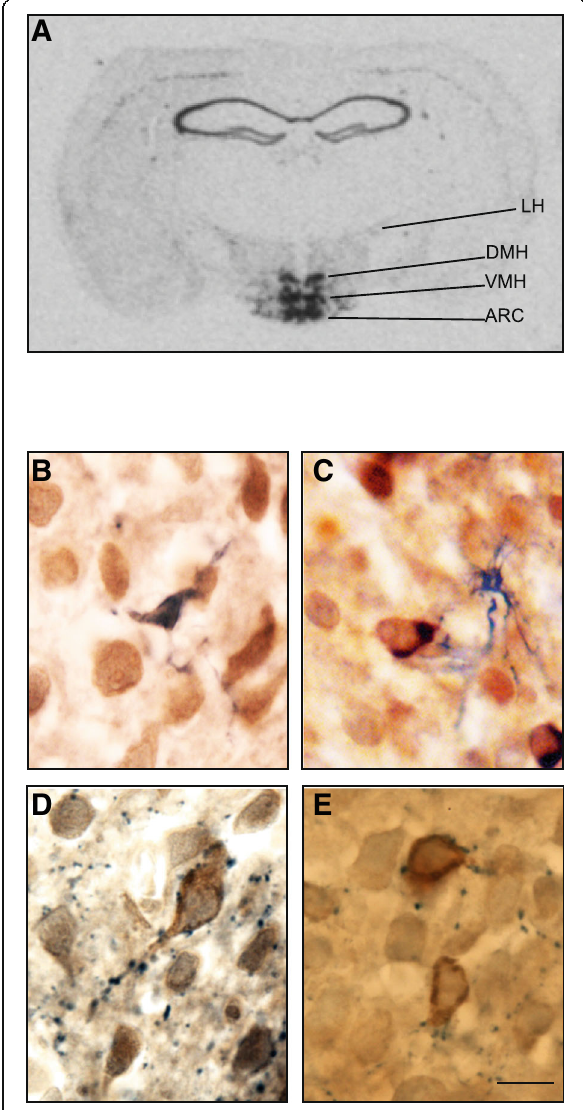
Fig. 2 a Representative in situ autoradiograph of a C57BL/6J mouse brain section after 4 weeks of HFD showing serpinA3N expression in the arcuate nuclei (ARC), the ventromedial nuclei of the hypothalamus (VMH), the dorsomedial nuclei of the hypothalamus (DMH) and the lateral hypothalamus (LH). b – e Representative immunostaining of α 1 AC (brown) and b GFAP, c Iba1, d AgRP and e NPY (all blue) in the arcuate nuclei after 1 week of HFD. Bar = 20 μ